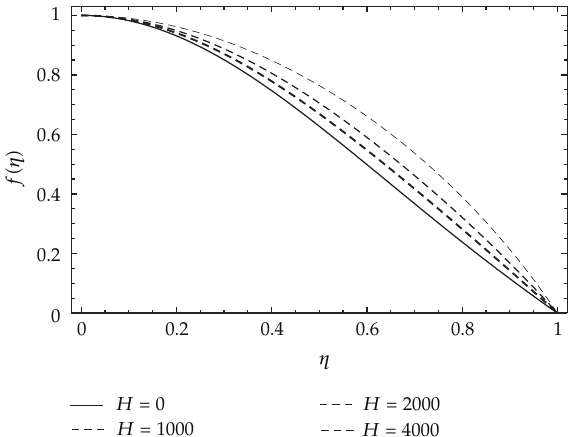
Figure 3: DTM solution for velocity in divergent channel for Re (cid:8) 100 and α (cid:8) 2 . 5 ◦ .